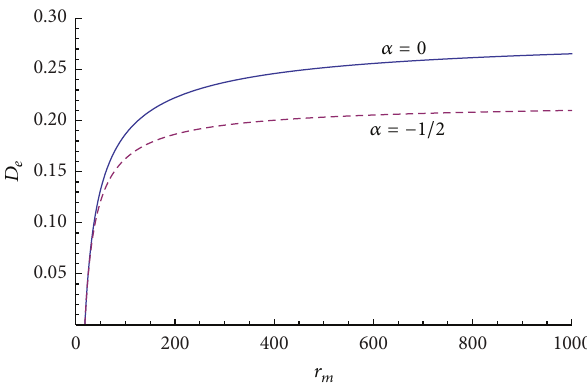
Figure 2: The RG flow of the charge diffusion constant, where we take 𝜂 = 1 , 𝑇 𝐻 = 1 , and 𝐷 = 4 . It shows that the charged diffusion constant increases monotonically with the energy scale denoted by 𝑟 𝑚 , and it becomes zero at the horizon